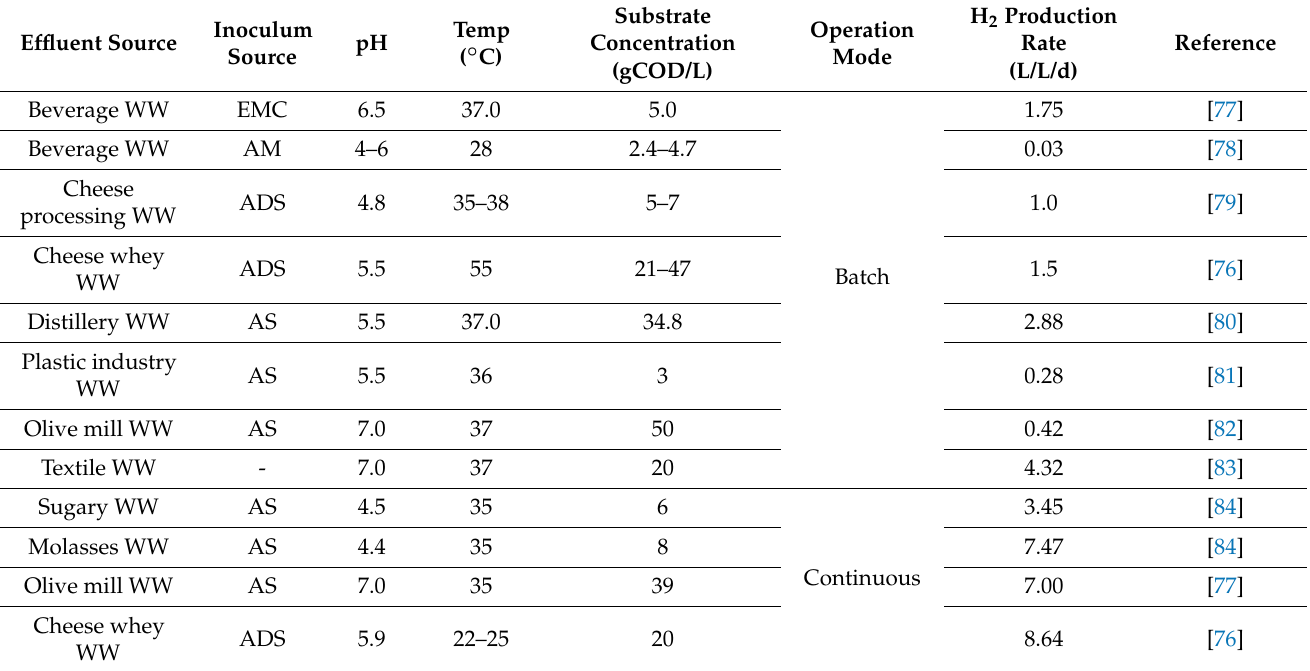
Table 8. Hydrogen production by dark